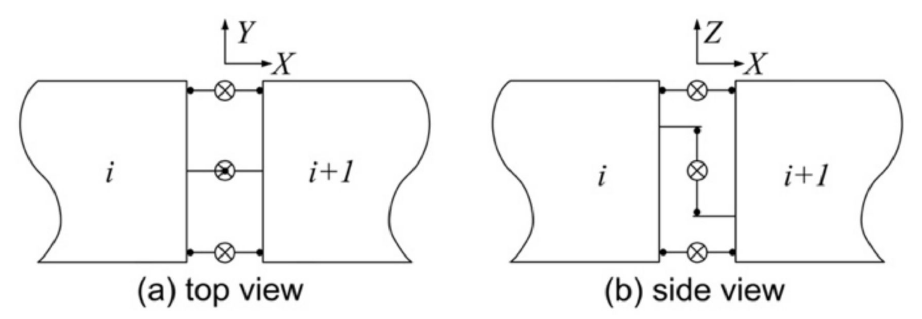
Figure 3. An arrangement of the connectors in between two adjacent modules to suppress the surge, heave, pitch, and yaw motions of the modular